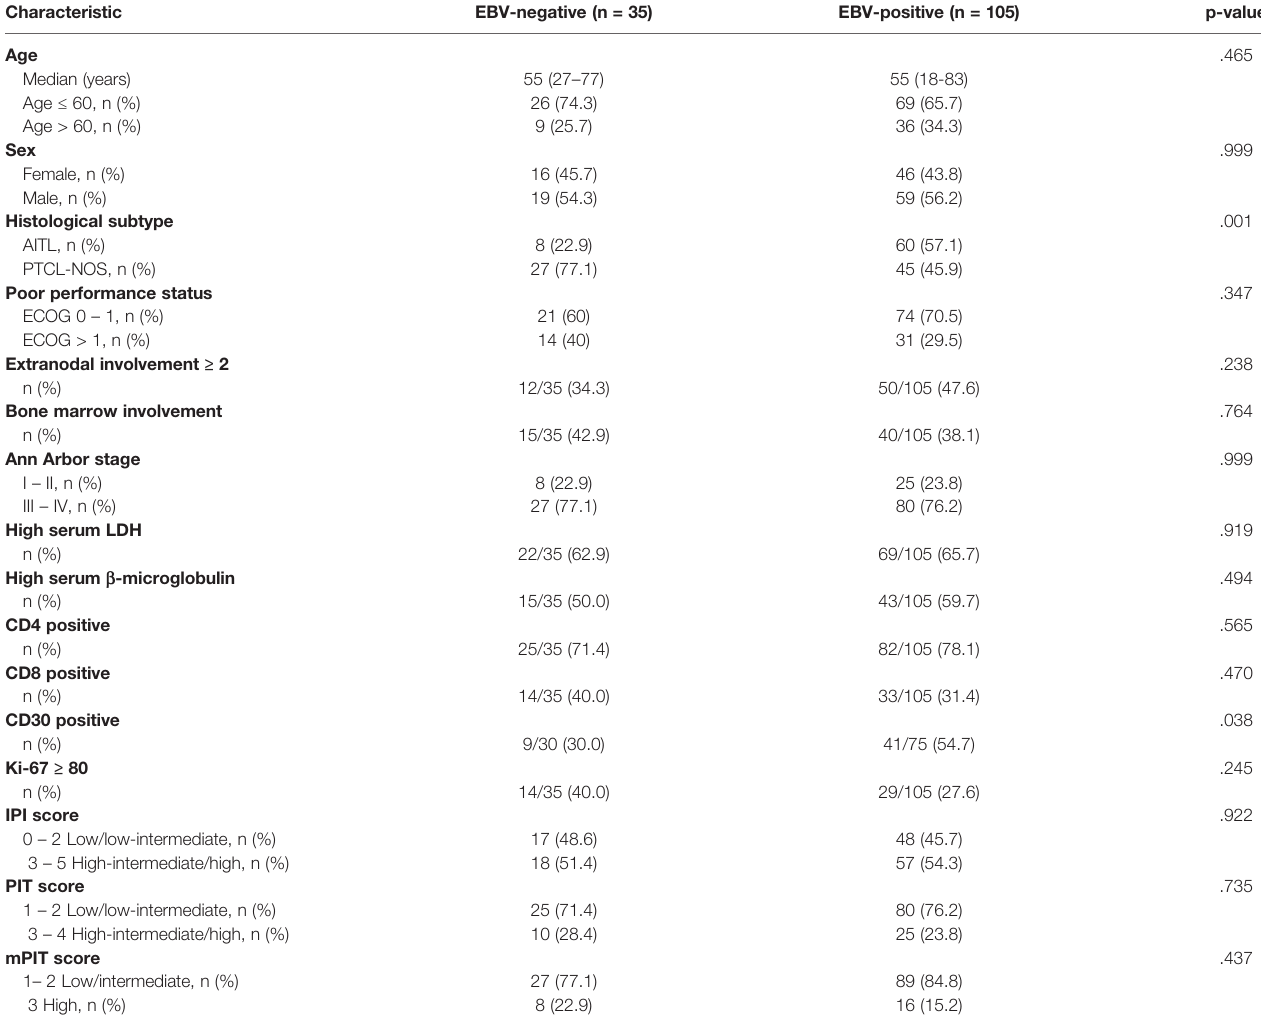
TABLE 1 | Characteristics of patients with PTCL-NOS or AITL.